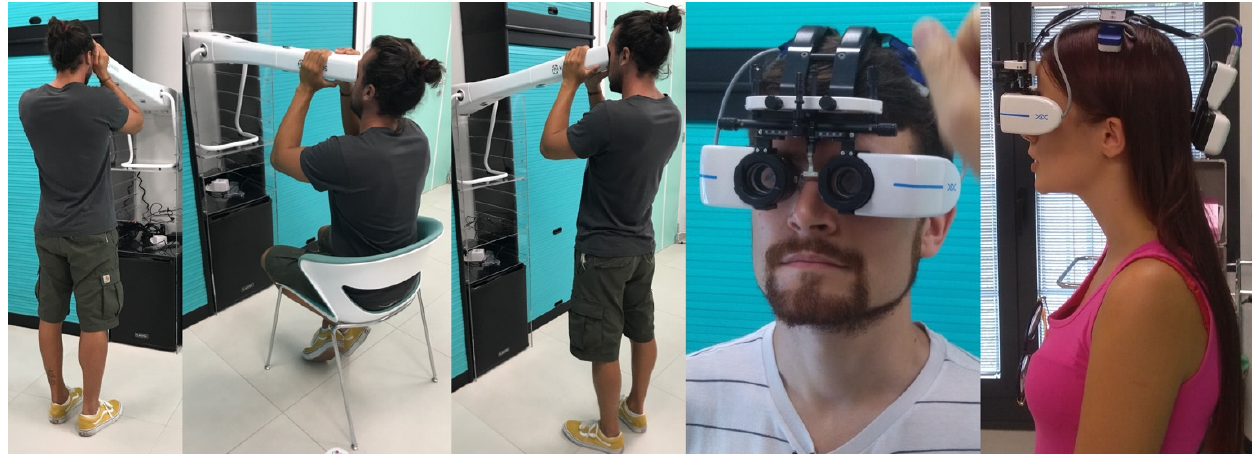
Figure 1. The different measurement conditions using Kaleidos in standing and seated position. The last 2 photos show measurement using VisionFit SC, an electronic wearable adaptive